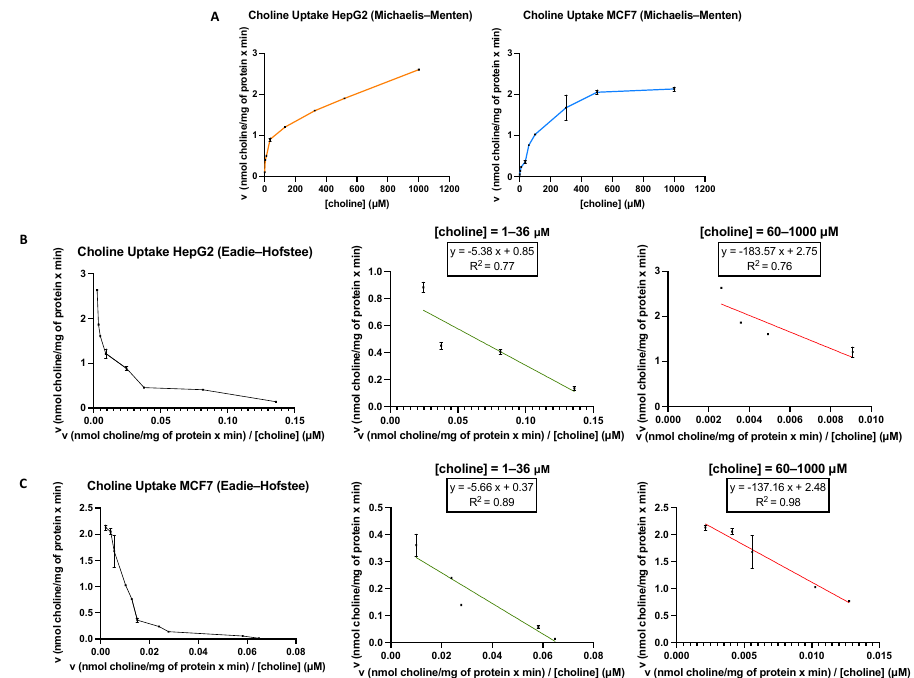
Figure 2. ( A ) [Methyl- 14 C]choline uptake by HepG2 and MCF7 cells was assayed for 10 min over a concentration range from 1 to 1000 µM choline. Representative Eadie–Hofstee plots for [methyl- 14 C]choline uptake in HepG2 ( B ) and MCF7 ( C ). The kinetic constants (K M and V max ) for transporter proteins were determined using equations from the Eadie–Hofstee plots obtained with low (1–36 µM) and high (60–1000 µM) choline substrate concentrations. Data are representative of two independent experiments performed in triplicate.